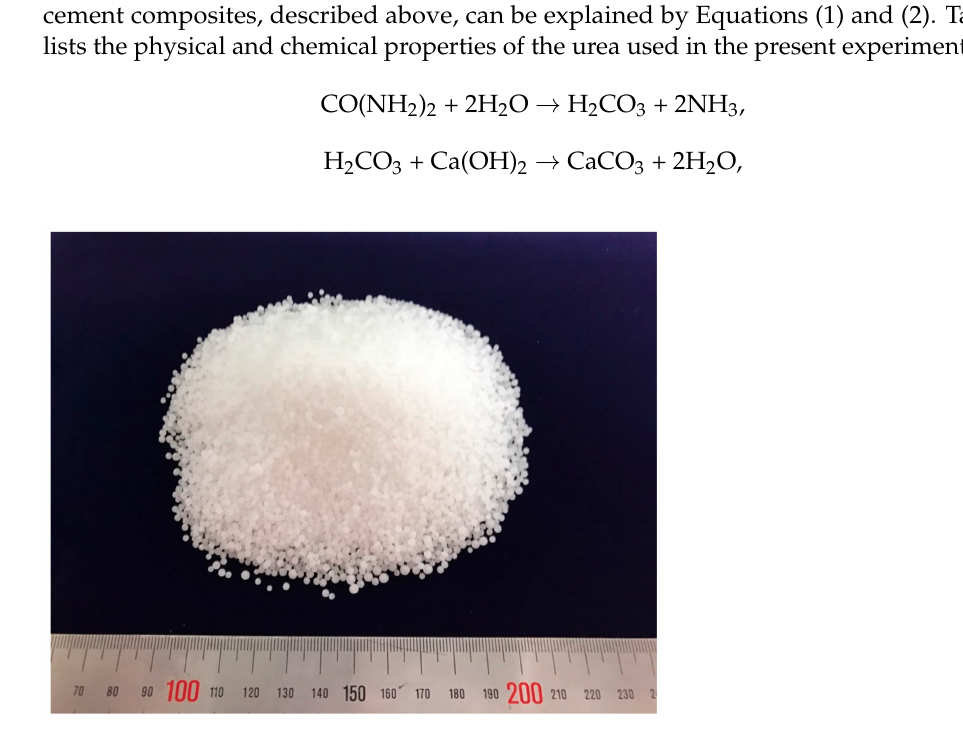
Figure 1. Industrial urea used in the current experiment. Table 1. Properties of industrial urea